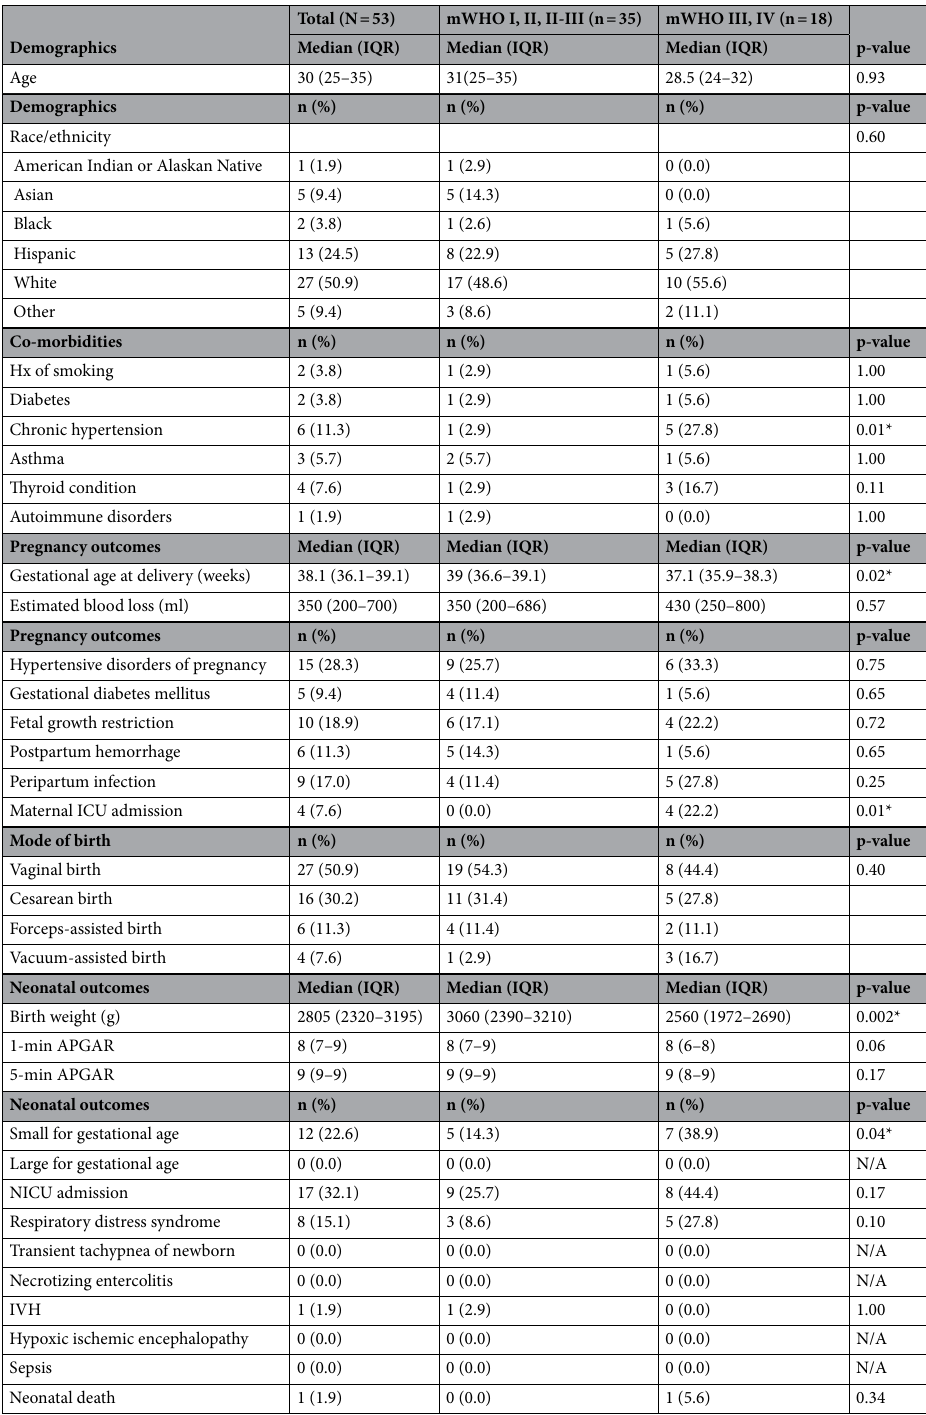
Table 1. Summary of maternal demographics, maternal clinical characteristics, pregnancy outcomes, and neonatal outcomes by classification of cardiovascular risk.